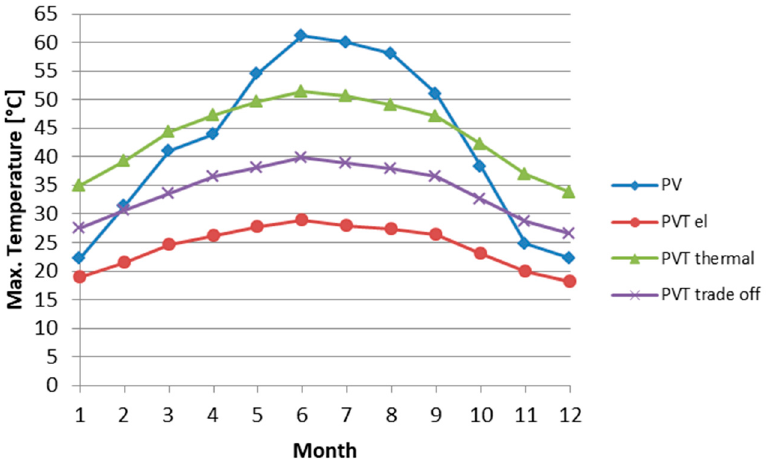
Figure 17. Monthly maximum PV cell operating temperatures in the PV panel and optimal PVT designs.